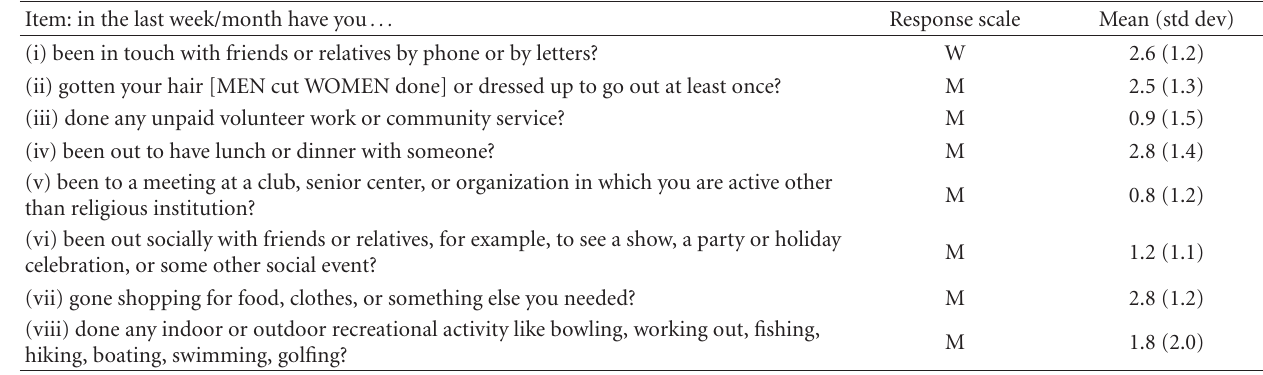
Table 5: Social engagement